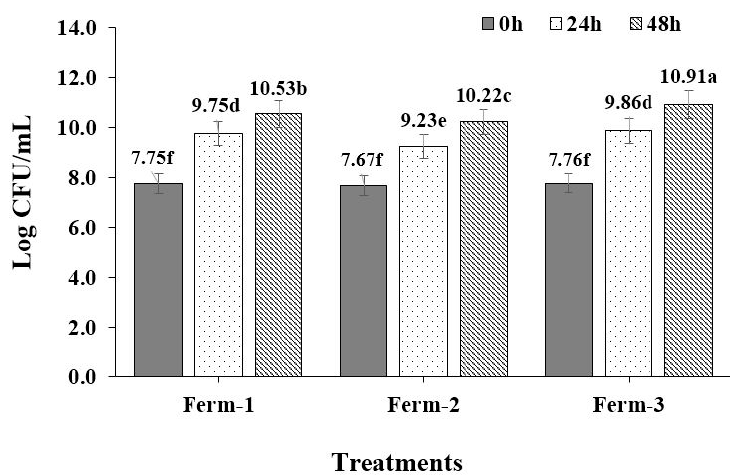
Figure 2. The viable yeast cells (log CFU/mL) at different fermentation hours. The bars with different letters indicate a significant difference ( p < 0.5) among treatments.